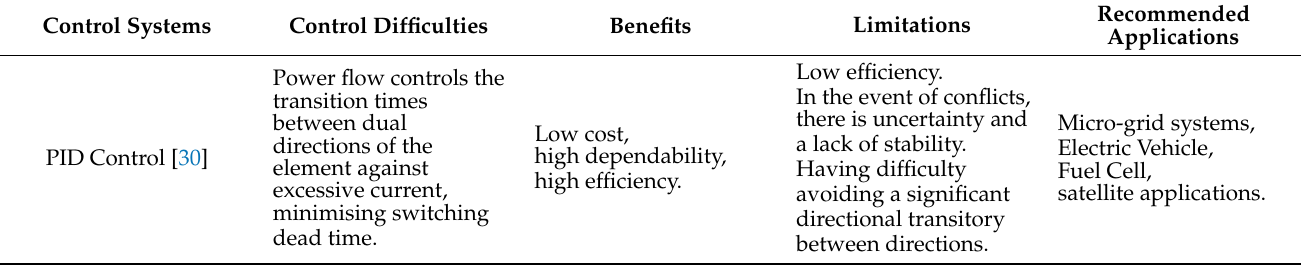
Table 4. An overview of control techniques used in bidirectional (DC-DC) converters. Control